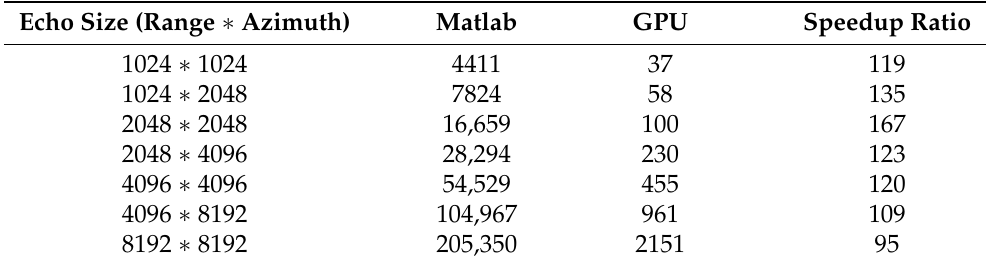
Table 3. Comparison of the execution time between the serial method implemented by Matlab and the parallel method implemented by the GPU (unit: